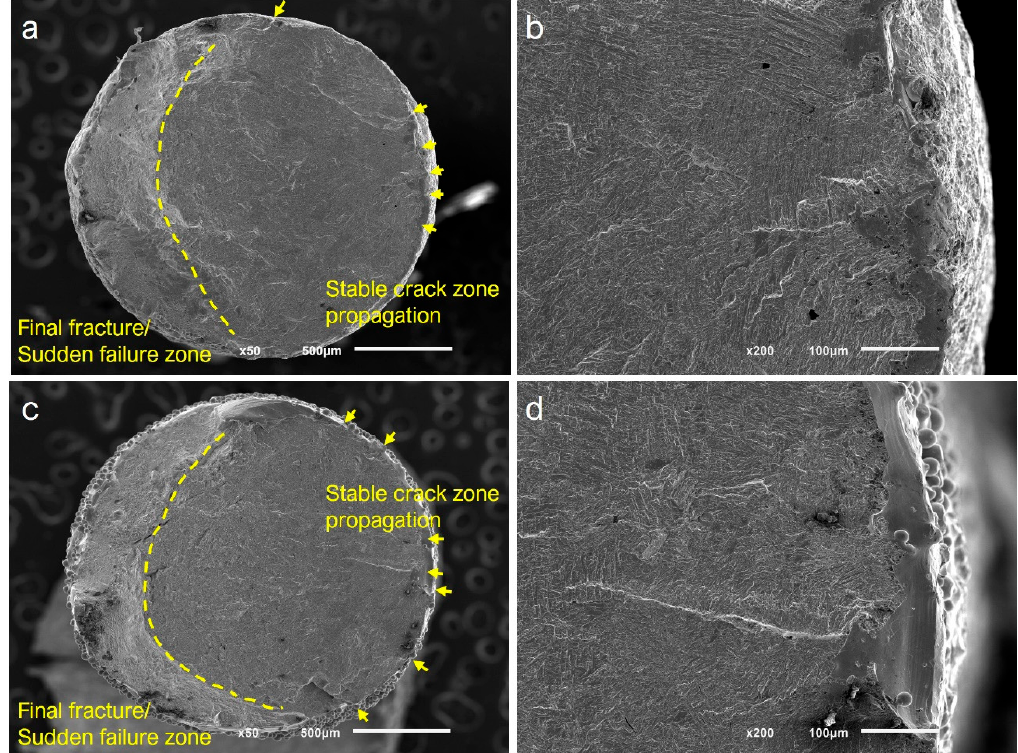
Figure 8. Representative SEM images of fracture surfaces after fatigue tests. ( a , b ) Samples fabricated with new powder; ( c , d ) samples fabricated with recycled powder. Multiple crack initiation sites at the surface (arrows) were observed for both powder conditions. The stable crack propagation zone and the final fracture zone are well delimited (dashed line).